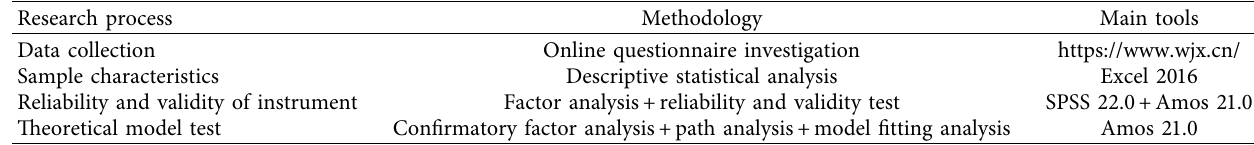
Table 3: Relationship between the research process, methodology, and analysis tools.